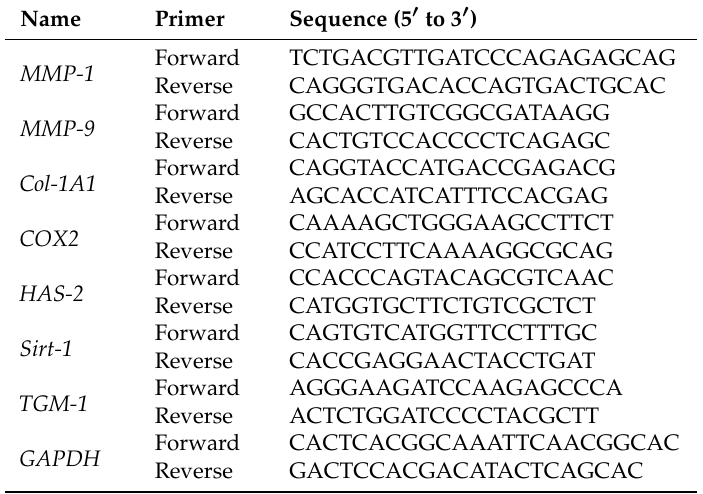
Table 1. Sequences of primers (human) used in semi-quantitative